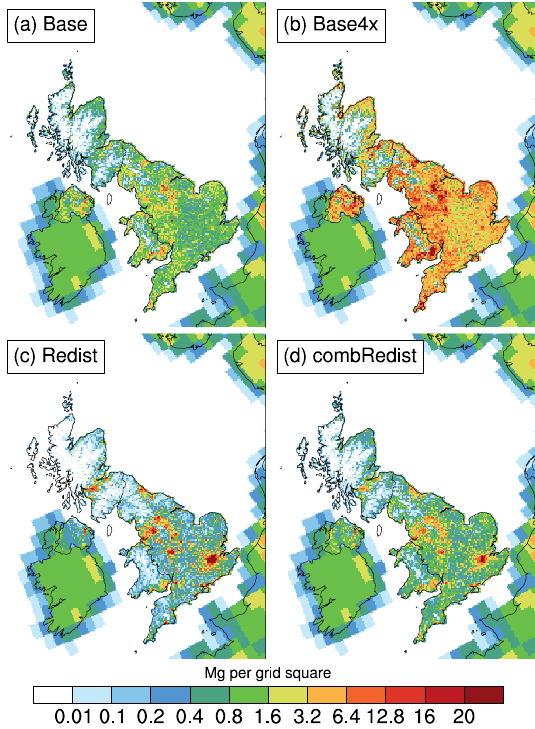
Figure 2. Total SFOA emissions (defined as 48% of PM 2 . 5 from SNAP2) for the year 2012 in the inner nesting domain for the four scenarios of this study: (a) Base : as in the NAEI, (b) Base4x : base increased by a factor of four over the whole of UK, (c) Redist : UK emissions redistributed to residential population density (national total same as Base), (d) combRedist : half of the total emission redis- tributed to residential population density, half as reported by NAEI (a combination of a and c ). The national total is the same for (a, c, d) . All UK emissions are aggregated to the 5km × 5km grid (20Mg per grid square is 0.8Mgkm − 2 ) from an initial resolution of 1km × 1km reported by the NAEI. The emission resolution is 50km × 50km for other countries (as in CEIP). Note the non-linear scale.